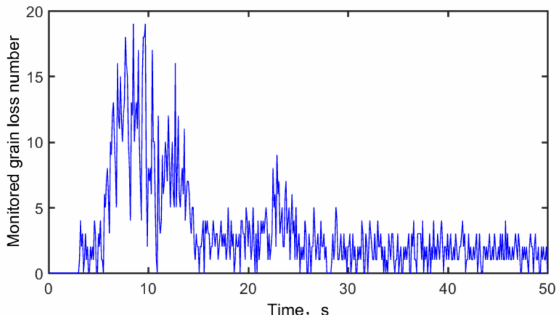
Figure 10. Comparison of grain sieve loss variation before and after activating the